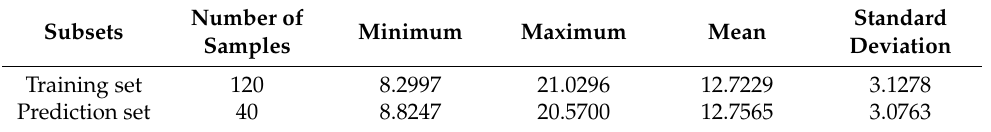
Table 1. The results of the mathematical statistics of the fatty acid values in the two sample subsets.